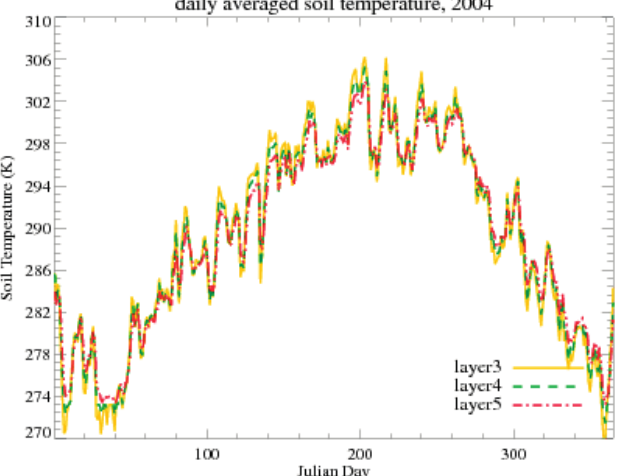
, T , T at the upper soil layer (T skin air soil ) for ( a ) January 2004 and ( b ) July 2004. The model soil5